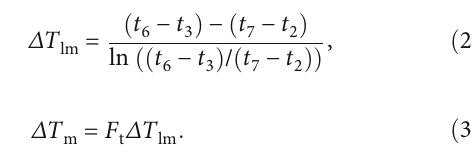
Table 2: Coe ffi cients n